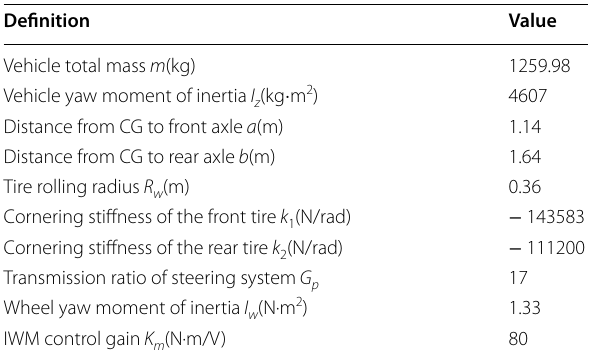
Figure 6 Simulation results of longitudinal velocity